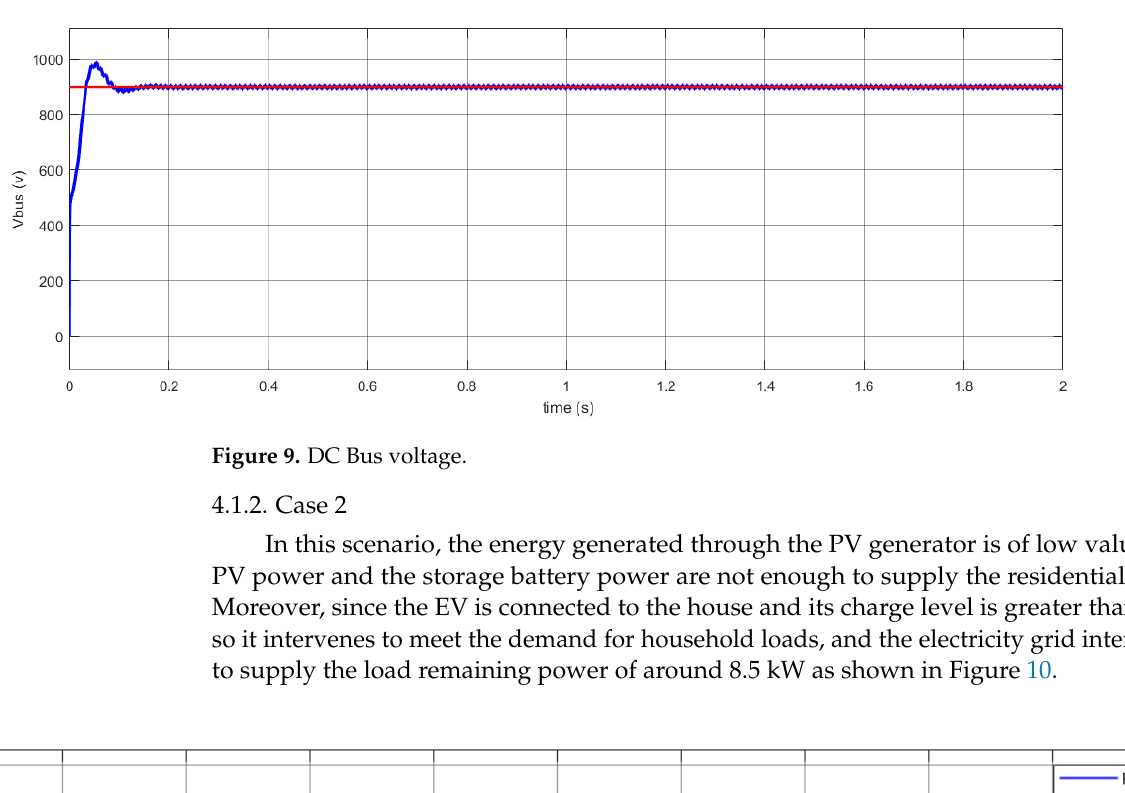
Figure 8. EV and ba tt ery charging from PV. ( a ) EV SOC. ( b ) ba tt ery SOC.